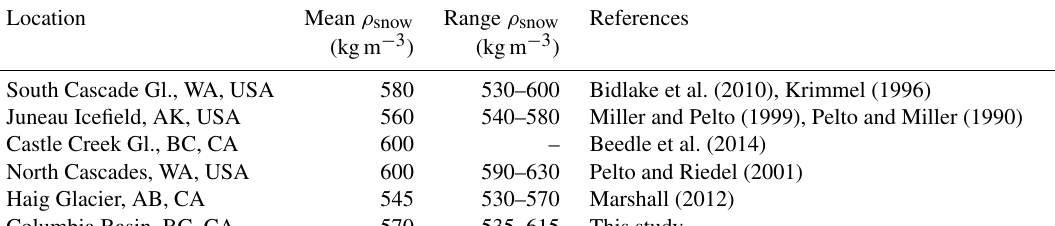
Table 5. Late summer snow density observations from regional studies. We use 570kgm − 3 as our density of late summer snow for geodetic mass balance but also separately calculate mass balance using the average for regional studies excluding those from glaciers in this study (590kgm − 3 ).